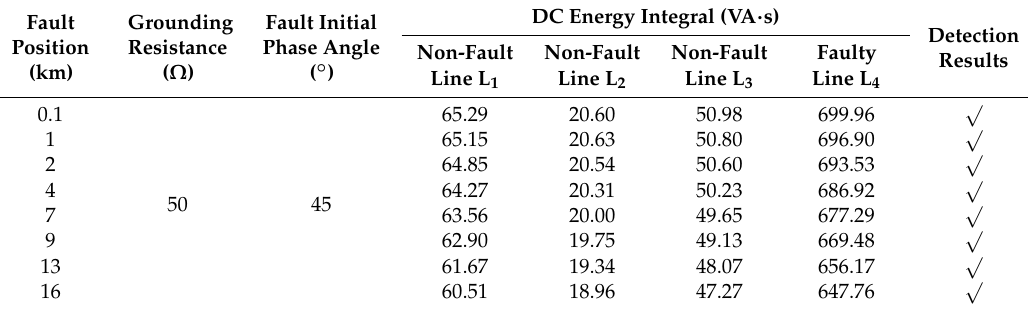
Table 6. DC energy integral under SPG faults with different fault locations.